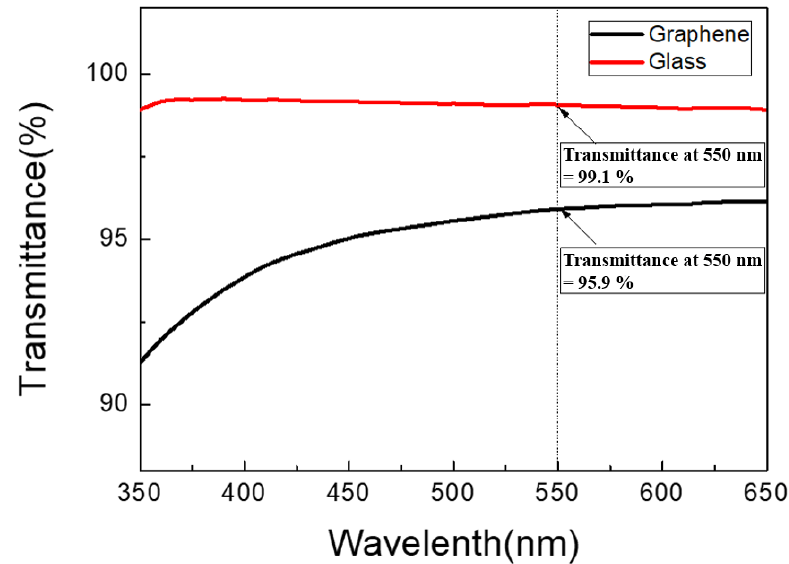
Figure 3. UV–visible transmittance spectrum of